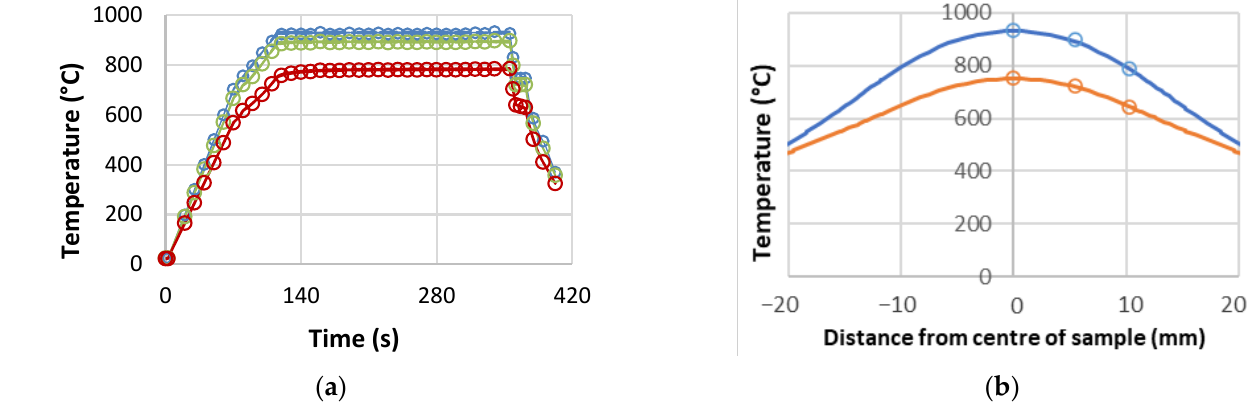
Figure 8. Comparison between numerical and experimental results in terms of ( a ) thermal cycles; ( b ) thermal gradient along longitudinal axis of the sample.